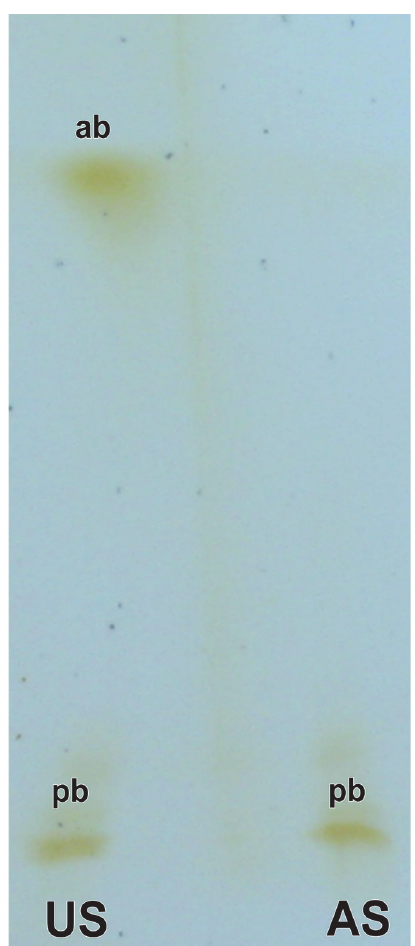
Figure 5 - Thin layer chromatography (TLC) of terpenoids and other volatile compounds from extracts of bark powder of the underground stem (US) and aerial stem (AS) of Tontelea micrantha. ab: more apolar band; pb: more polar